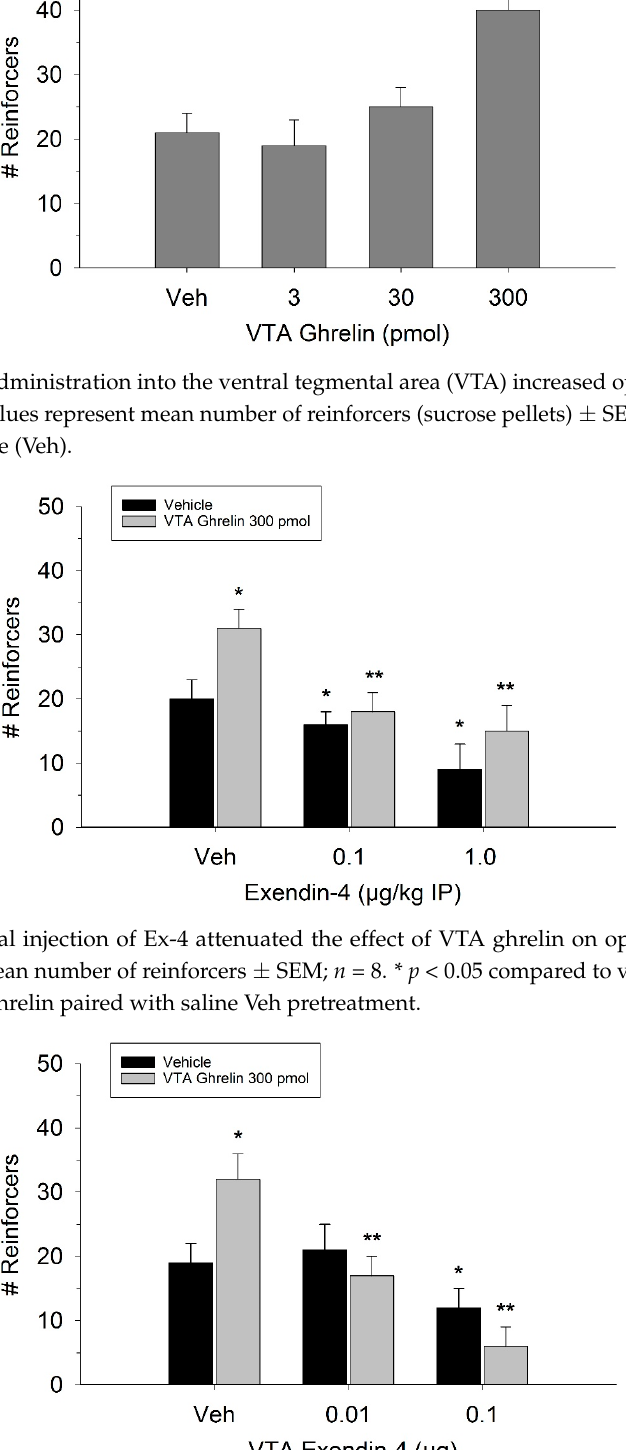
Figure 4. Systemic administration of the 5-HT 2c agonist Ro60-0175 attenuated the effect of VTA ghrelin on operant responding for food reward. Data are presented as mean number of reinforcers ± SEM; n = 8. * p < 0.05 compared to vehicle (Veh). ** p < 0.05 compared to ghrelin administered with saline pretreatment.